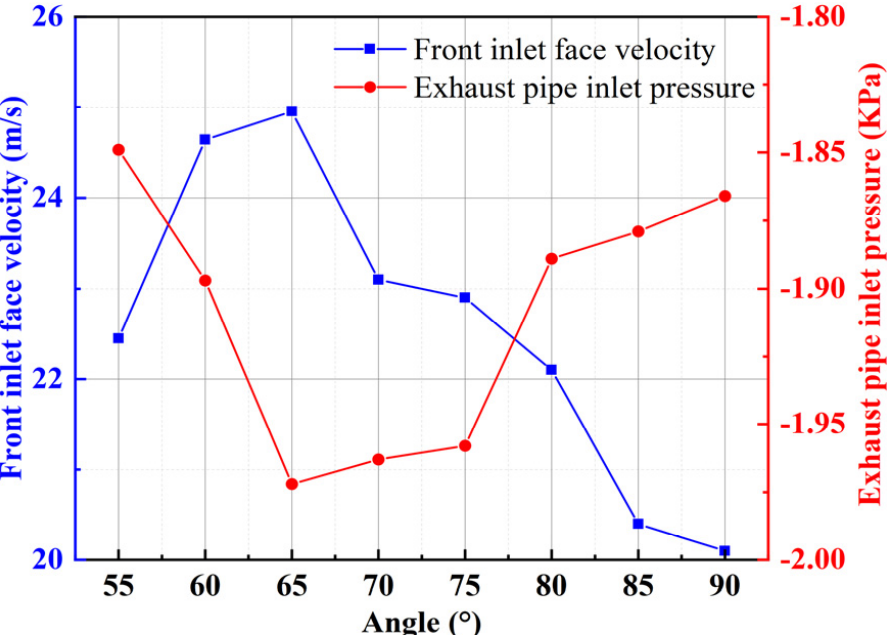
Figure 8. Influence of the angle of inclination of the front inlet surface on the flow field characteris- tics.